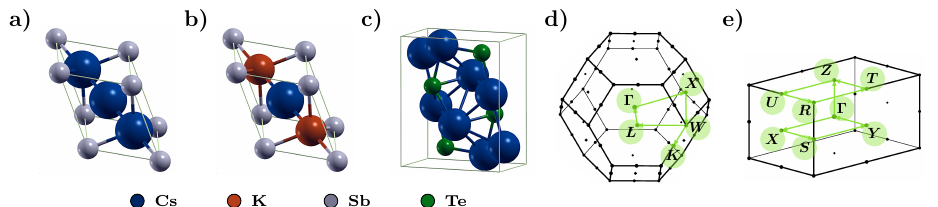
Figure 2. Ball-and-stick representation of the primitive unit cells of ( a ) Cs 3 Sb, ( b ) CsK 2 Sb, and ( c ) Cs 2 Te. Brillouin zone of ( d ) Cs 3 Sb and CsK 2 Sb and ( e ) Cs 2 Te with the high-symmetry points and the paths connecting them being highlighted in green. Plots produced with the visualization software XCrysDen